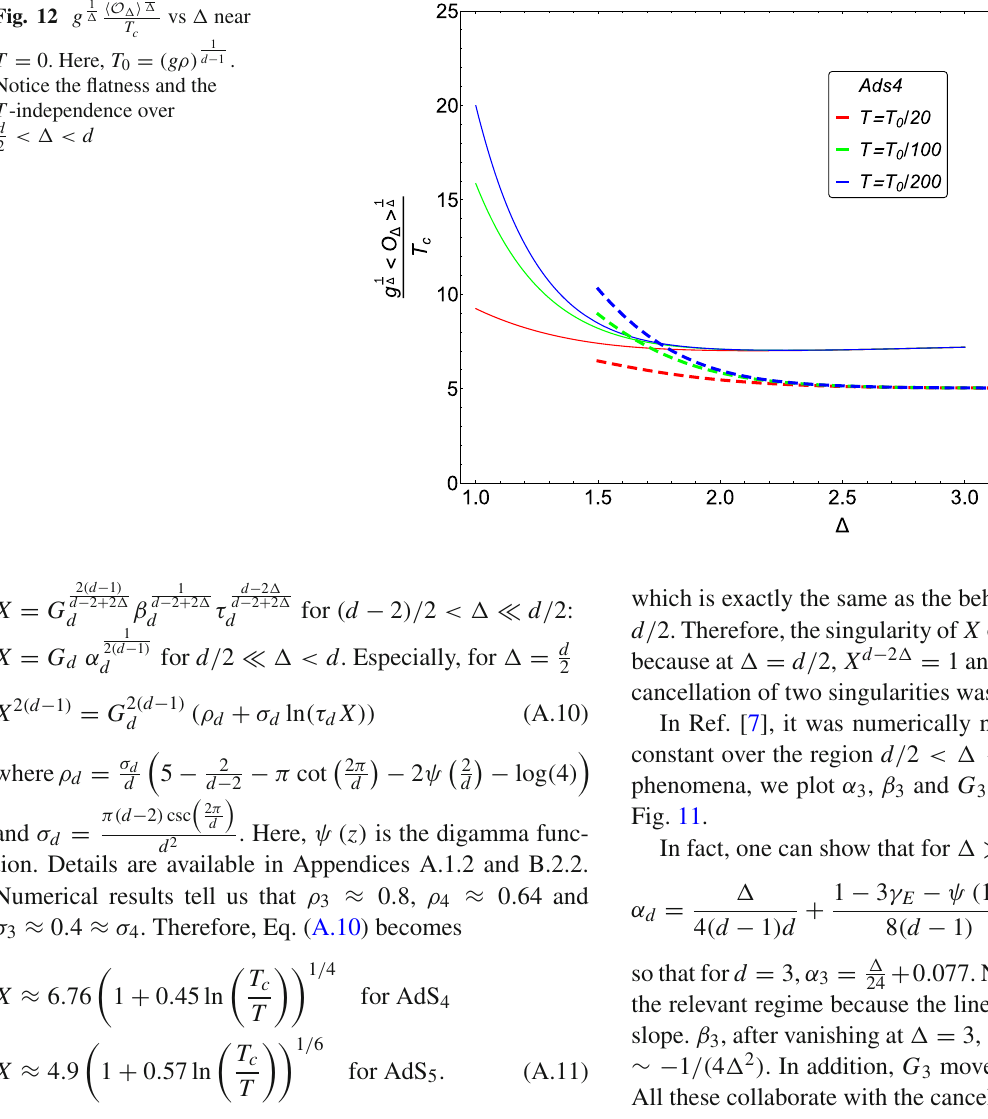
1 (cid:2) vs (cid:2) near T c 1 d − 1